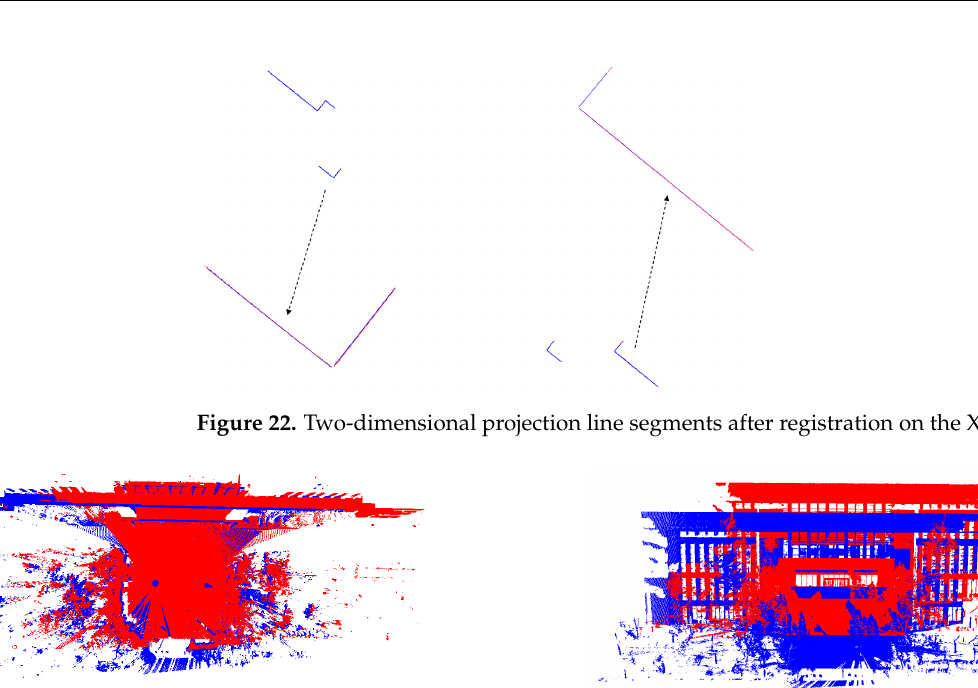
Figure 21. Line segments that can be matched; 1, 2, 3, 4, and 5 correspond to a, b, c, d, and e.